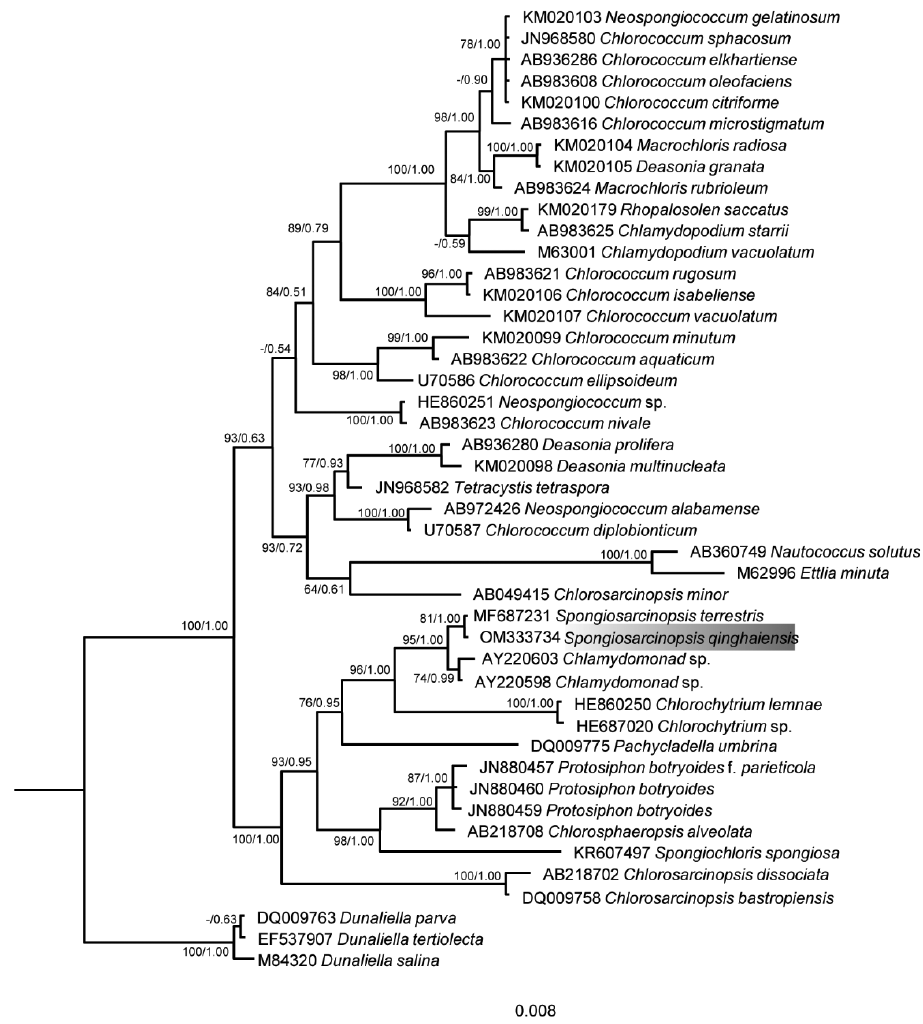
Figure 11. Phylogenetic tree constructed by Bayesian approach based on 18S rDNA sequences. Maxi- mum likelihood bootstrap values and Bayesian posterior probabilities are given on nodes. Values above 0.50 for BI and 50 for ML are given. The gray part shows the new species of this